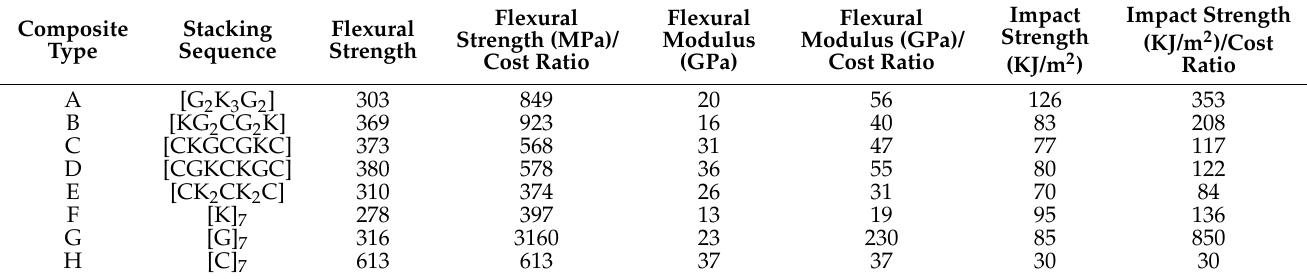
Table 4. Comparison of flexural strength and modulus/cost and impact strength/cost of